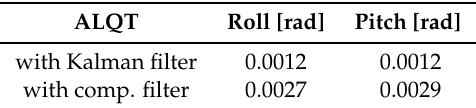
Table 3. Mean square error of e ϕ .